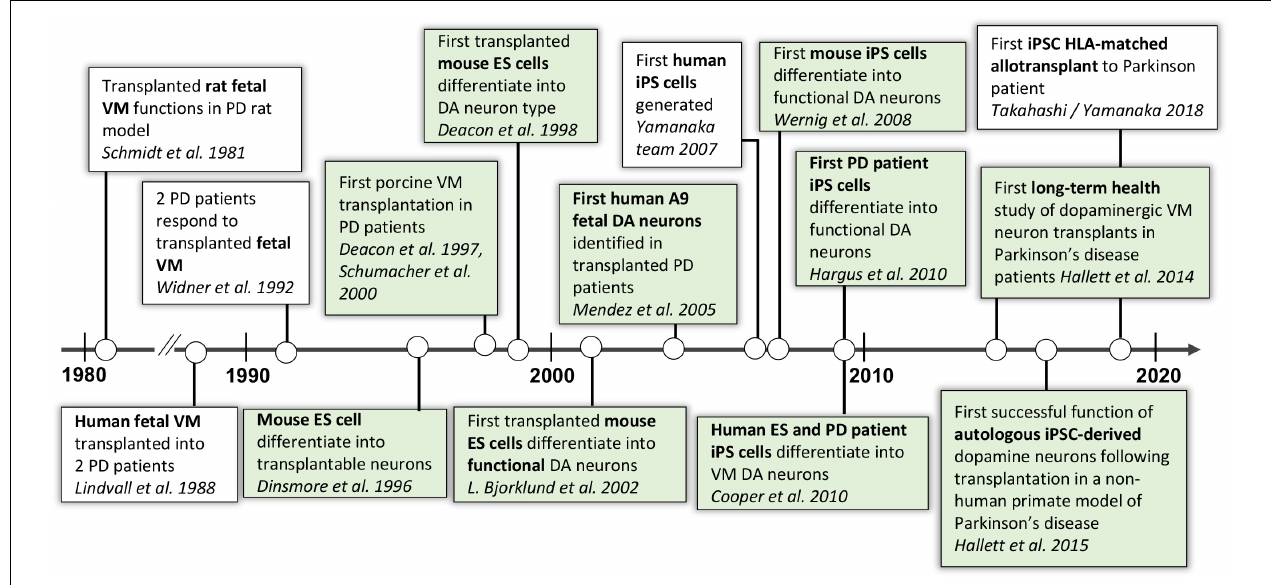
FIGURE 3 | Progression of autologous cell therapy for Parkinson’s disease. In green are the discoveries and publications that have contributed to this timeline by the authors and their collaborators (Schmidt et al., 1981; Lindvall et al., 1988; Widner et al., 1992; Dinsmore et al., 1996; Deacon et al., 1997, 1998; Fink et al., 2000; Schumacher et al., 2000; Bjorklund et al., 2002; Mendez et al., 2005; Takahashi et al., 2007; Wernig et al., 2008; Cooper et al., 2010; Hargus et al., 2010; Hallett et al., 2014,